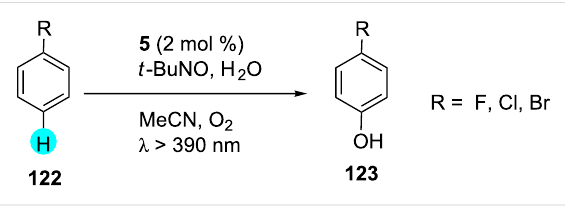
Scheme 19: Synthesis of substituted phenols with DDQ ( 5 ).